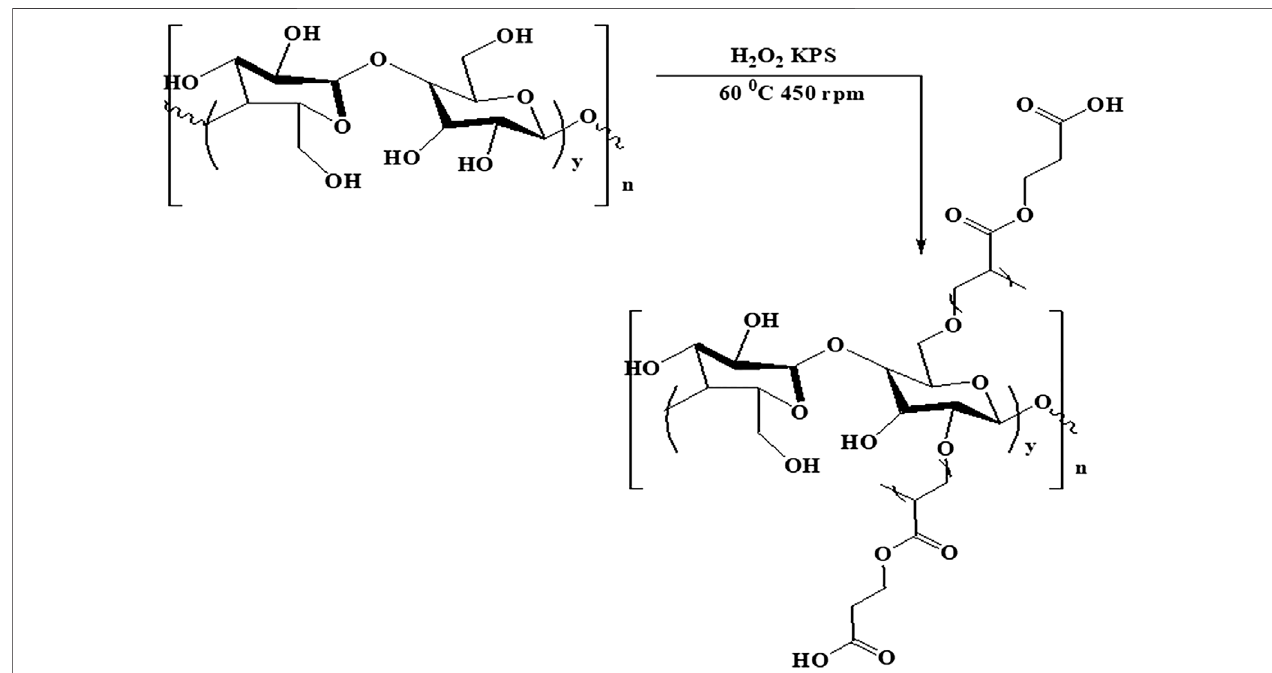
FIGURE 2 | Chemical synthesis of CNCs- g -poly (2-carboxyethyl acrylate).